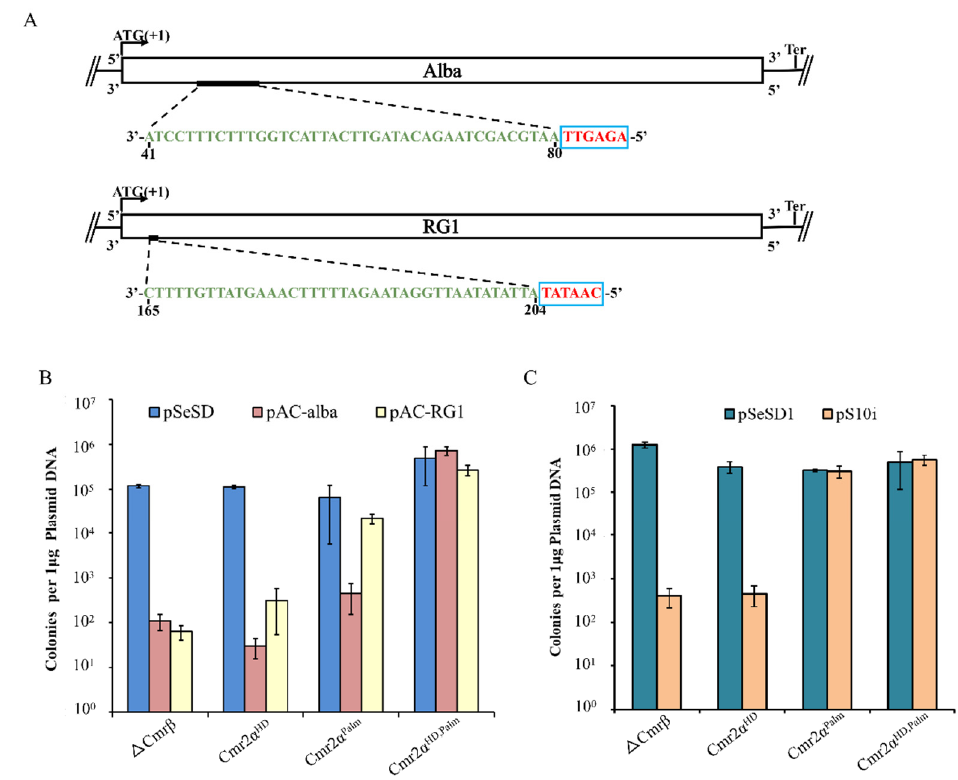
Figure 2. The Cmr2 α -based activities are not equally efficient in mediating the antiviral defense. Self-targeting activity in the cmr2 α mutant strains. ( A ) Outline of designed target sites for testing Cmr- α immunity in S. islandicus . ( B ) The control plasmid pSeSD1 and the self-targeting plasmids pAC-alba and pAC-RG1 were transformed into ∆β E233(WT) and the cmr2 α mutant strains, respectively, and the transformation efficiency was calculated. ( C ) The control plasmid pSeSD1 and the self-targeting plasmid pS10i were transformed into ∆β E233(WT) and the cmr2 α mutant strains, respectively, and the transformation efficiency was calculated. Alba encodes a crenarchaeal chromatin protein; RG1 codes for a reverse gyrase